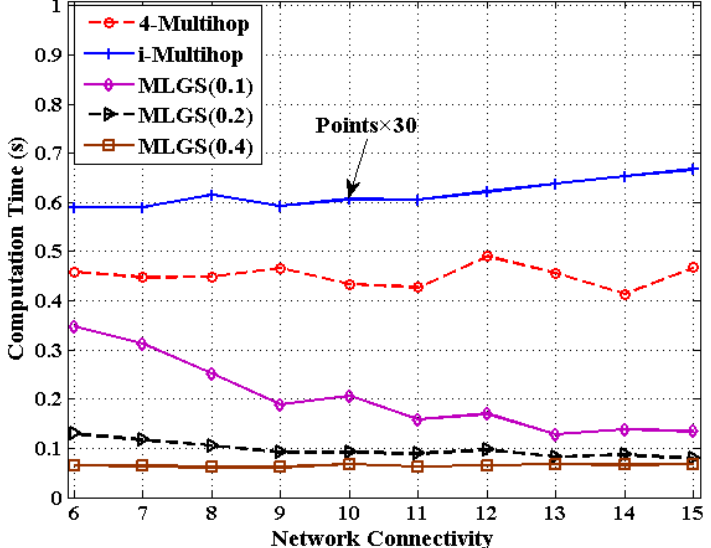
Figure 21. Computation cost versus network connectivity (anisotropic